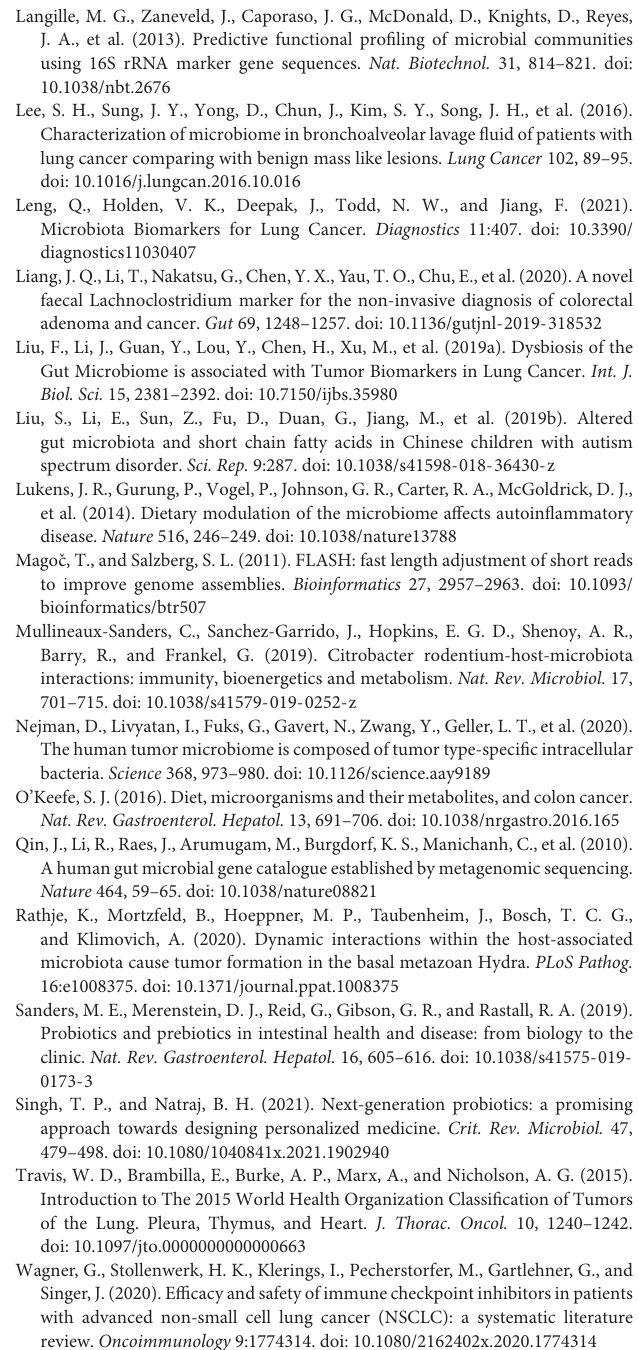
Supplementary Figure 1 | Sequencing data. (A) Quality sequence length distribution map. (B) OTU rarefaction curves of intestinal flora in four groups